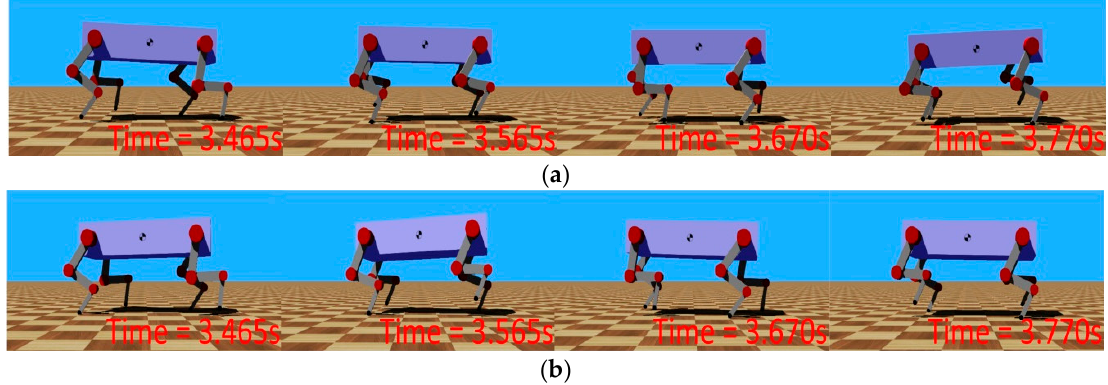
Figure 15. The simulation of the movement running at V desire =2m/s with trot gait: ( a ) The quadruped robot runs by the spline curve trajectories and ( b ) the quadruped robot runs by the Bézier curve trajectories.